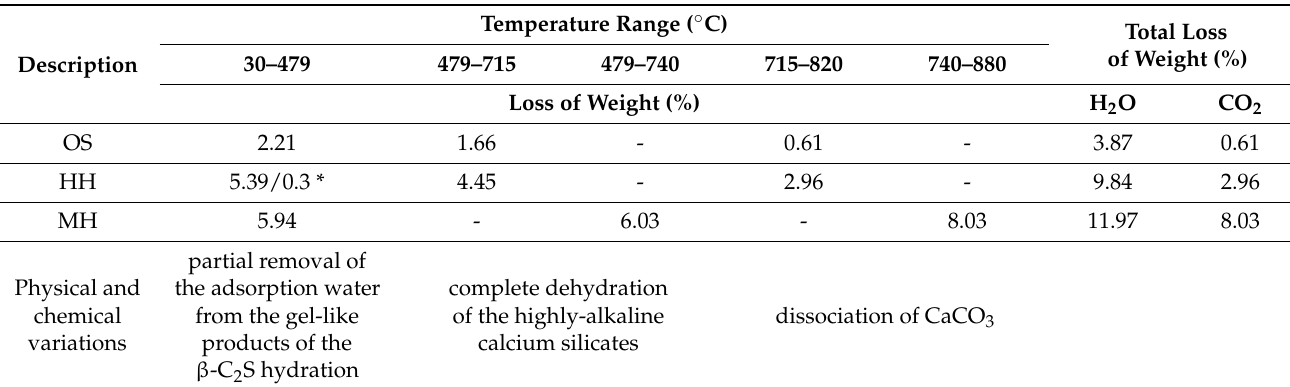
Figure 6. Results of the TG analysis of the OS, HH, and MH samples. Table 8. Detailed analysis of variation of the weight of the investigated samples within the relevant temperature ranges depending on the nepheline sludge hardening